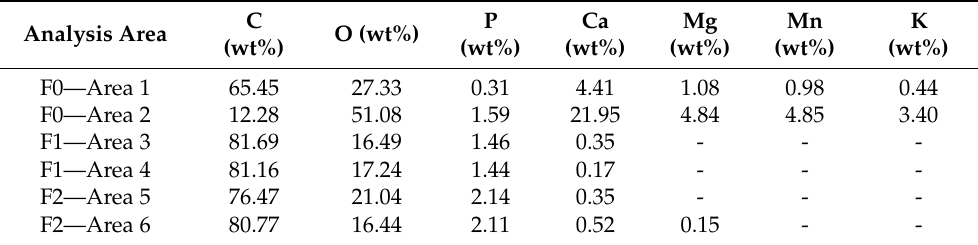
Table 5. Elemental composition analysis performed on different areas (identified on Figure 11) of the cone calorimeter